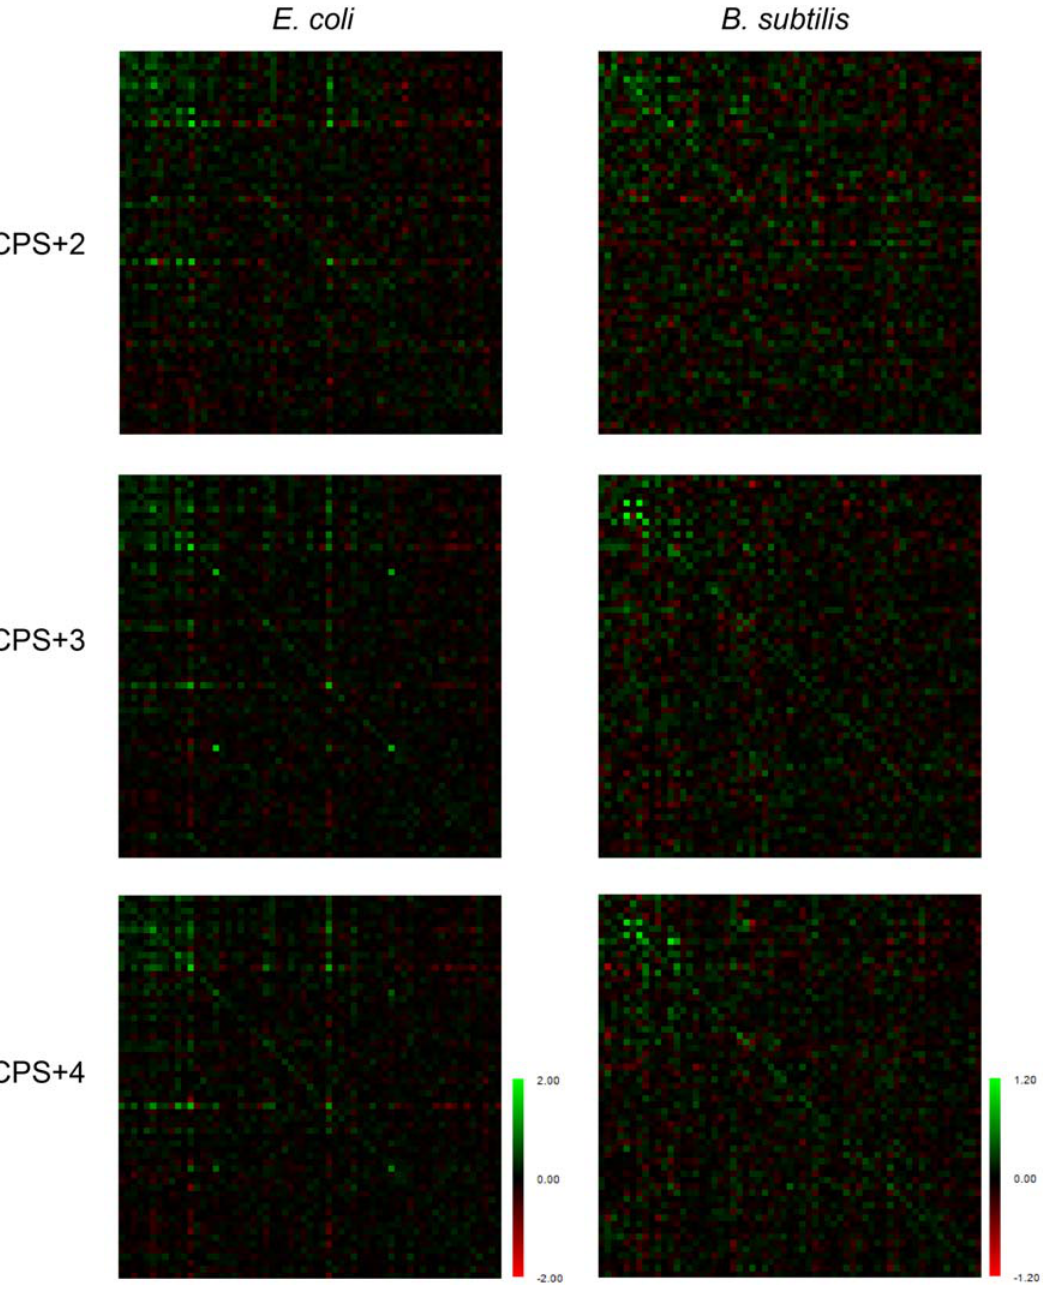
Figure 3. Graphical view of CPS + n matrices in E.coli and B.subtilis . On the horizontal and vertical axes, codons with gradually increasing tRNA concentrations are plotted, starting with the codon that pairs to the rarest tRNA; the slow-translating codons are located at the upper-left corner. Green spots represent the codon pairs which would appear more frequently in close proximity in the actual sequence than in the fully randomized sequence; the red color is used to highlight codon pairs that would appear less frequently. A common color of a submatrix represents an equal probability of occurrence of codons with similar tRNA concentration in a close proximity, and the intensity reflects the probability.